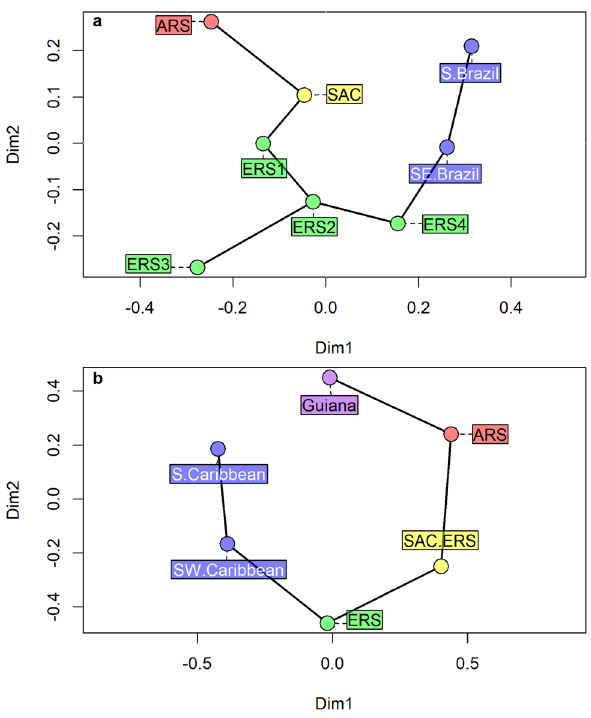
Figure 5. Ordination analyses (Sammon mapping) of South Atlantic reef systems and biogeographic regions based on the Sørensen dissimilarities among their marine biotas. ( a ) Analysis on a dataset with 2412 reef species, published by Ref. 51 , ( b ) analysis on a dataset with 8375 marine species, published by Ref. 50 . A minimum spanning tree was superimposed to the ordination graph in order to highlight putative connection pathways among regions 52,53 . Note that SAC is between ARS and ERS in both cases. ARS Amazon reef system, SAC Brazilian semi-arid coast reef system, ERS Eastern Brazilian reef system.